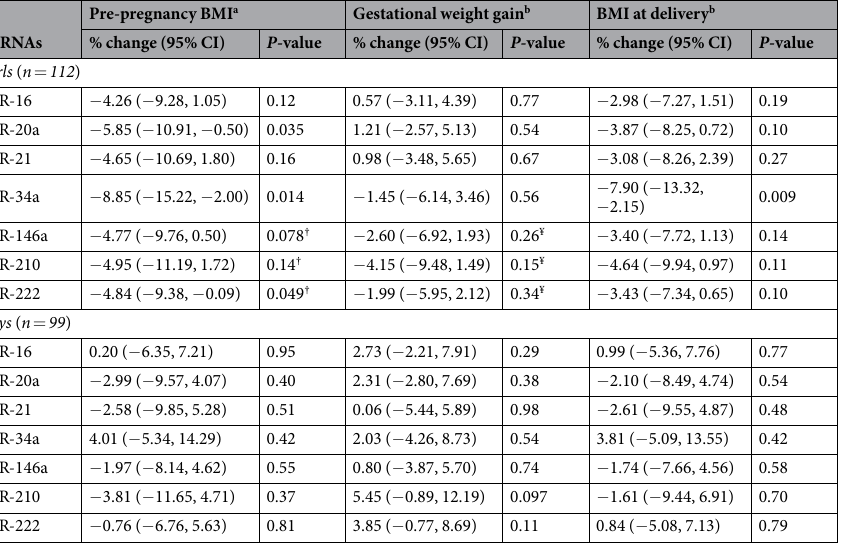
Table 3. Changes (%) in placental relative miRNA expression associated with maternal pre-pregnancy BMI, gestational weight gain and BMI at delivery. Estimates (95% confidence intervals) for a 1 kg/m 2 increase in BMI or for a 1 kg increment in gestational weight gain. a Adjusted for newborn’s ethnicity and gestational age, maternal age, smoking status, educational status, parity, gestational weight gain, health complications, delivery by C-section and outdoor temperature during the third trimester of pregnancy. b Adjusted for same set of covariates except gestational weight gain. † Additionally adjusted for the interaction between pre-pregnancy BMI and gestational weight gain. Estimate for a gestational weight gain of 14 kg (50 th percentile). ¥ Additionally adjusted for the interaction between pre-pregnancy BMI and gestational weight gain. Estimate for a pre- pregnancy BMI of 23 kg/m 2 (50 th